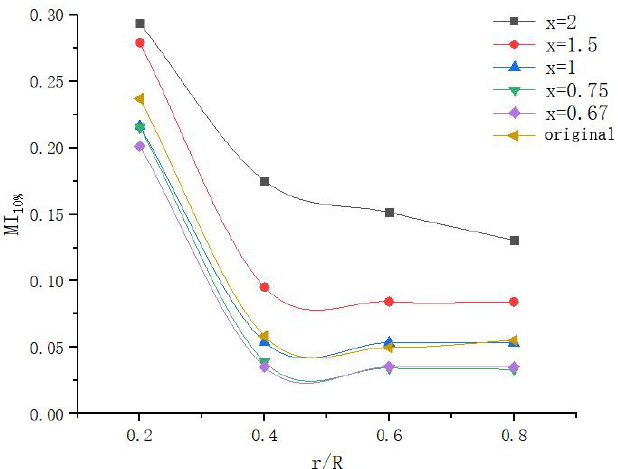
Figure 13. Influence of different scale-up criteria on the MI curve with 10% solid volume fraction.